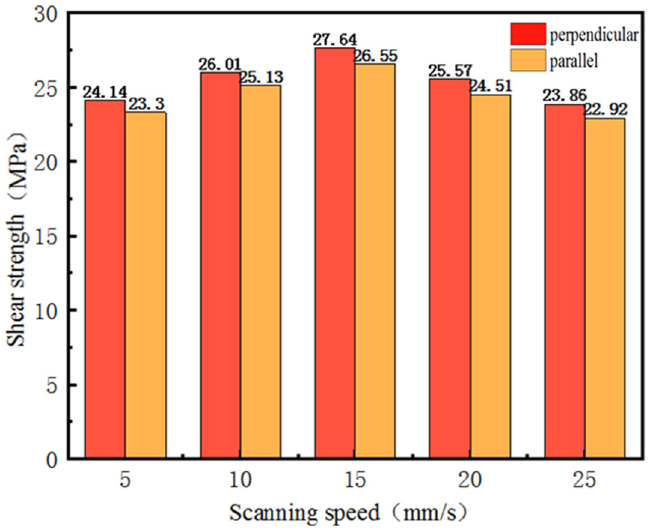
Figure 11. The shear strength of samples with different laser scanning